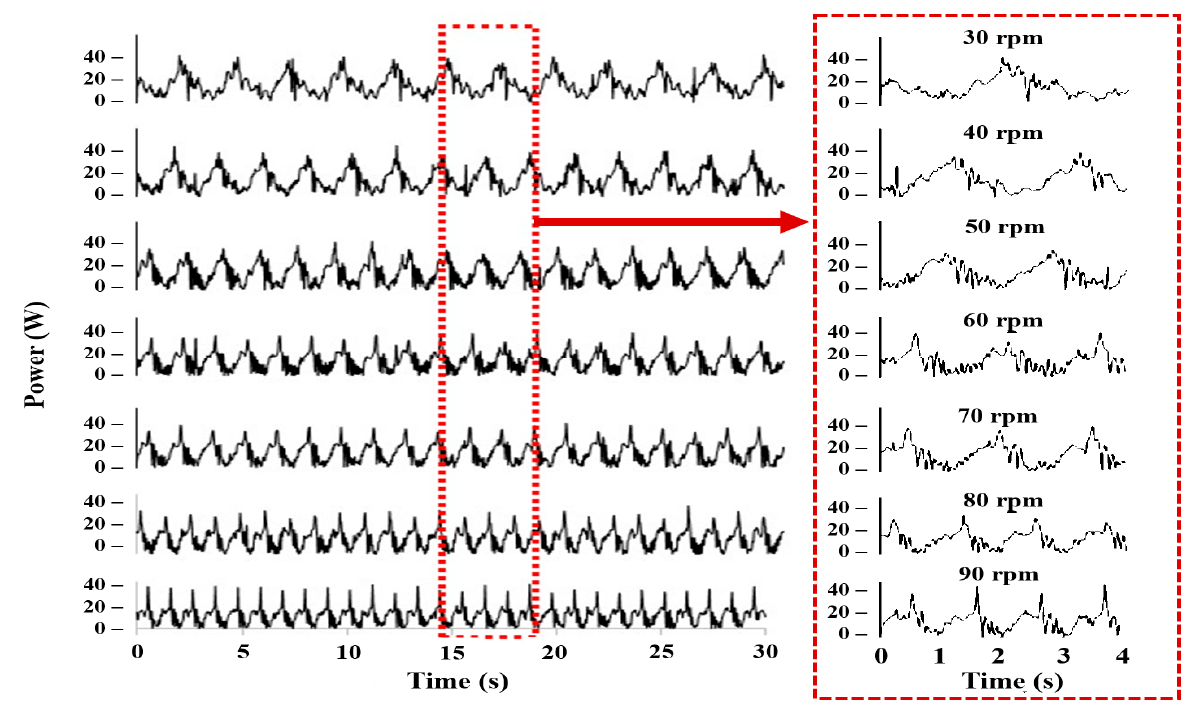
Figure 13. Power requirement for the planting mechanism at different rotational speeds.